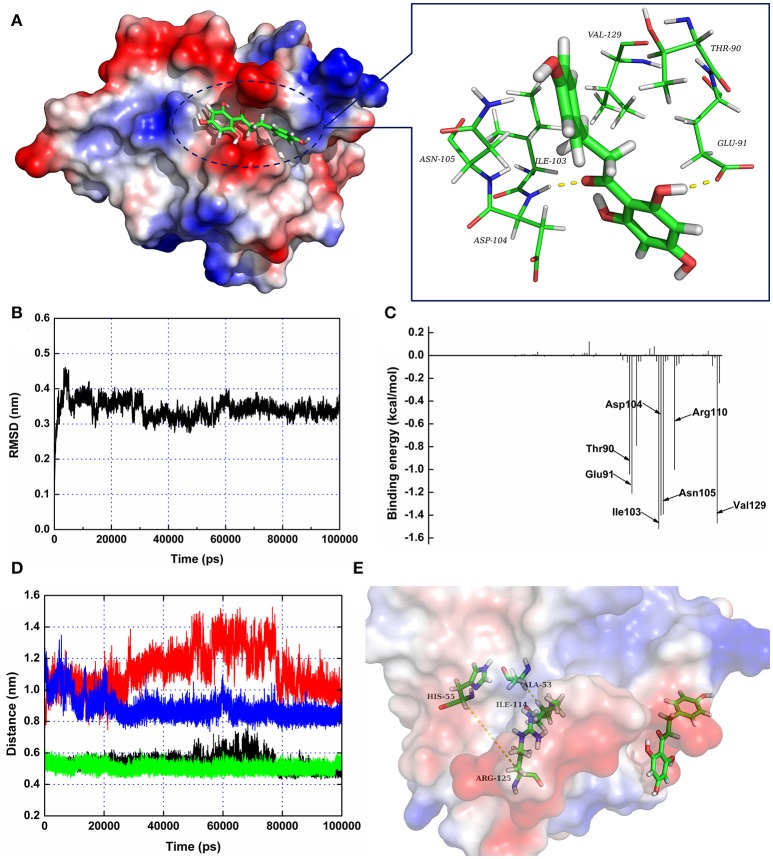
The 3D structure of SrtA in complex with phloretin determined by molecular modeling. (A) The 3D structure of the SrtA-phloretin complex. (B) The RMSD values of the backbone atoms of SrtA during MD simulations of the binding of SrtA to phloretin. (C) Decomposition of binding energy on a per-residue basis for the residues in the binding site of SrtA as the SrtA-phloretin complex formed. (D,E) Distances between Ala53-Ile114 and His55-Arg125 as a function of time. The black line (Ala53-Ile114 in the protein complex), red line (His55-Arg125 in the protein complex), green line (Ala53-Ile114 in free protein) and blue line (His55-Arg125 in free protein) represent the distances between the same residues.